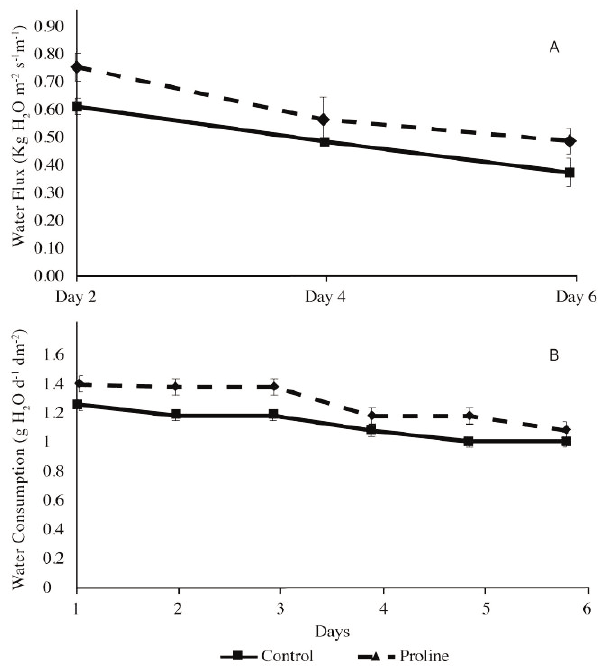
Fig. 1 - Effect of exogenous L-Proline on water flux (A) and water consumptions per leaf area (B) of rose cut stems during storage. Vertical bars indicate ± SE of means.